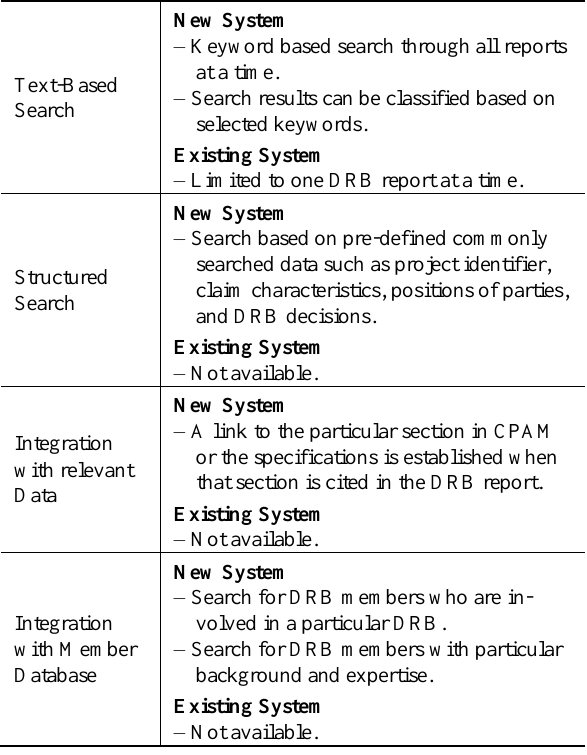
Table 2. Comparison of the existing and new DRB